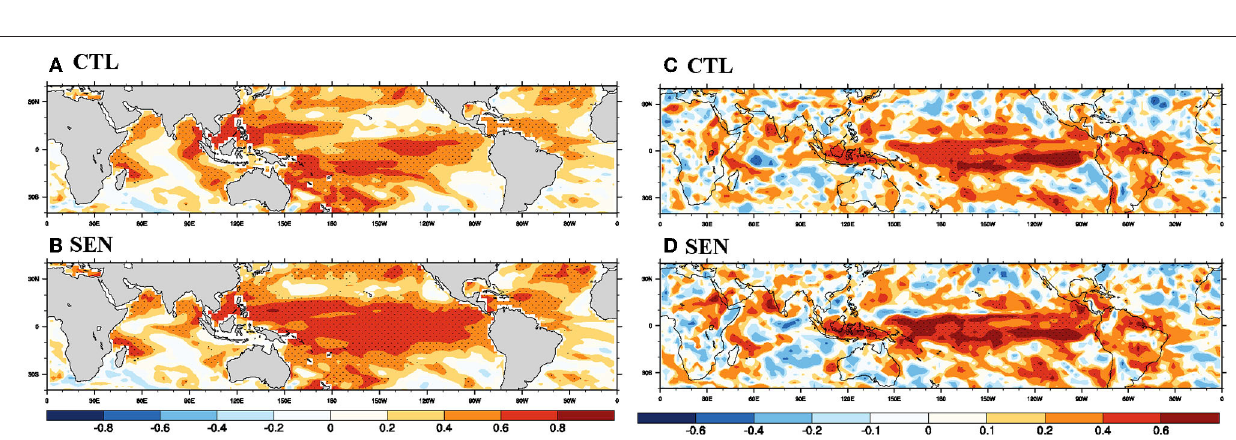
Frontiers in Climate |